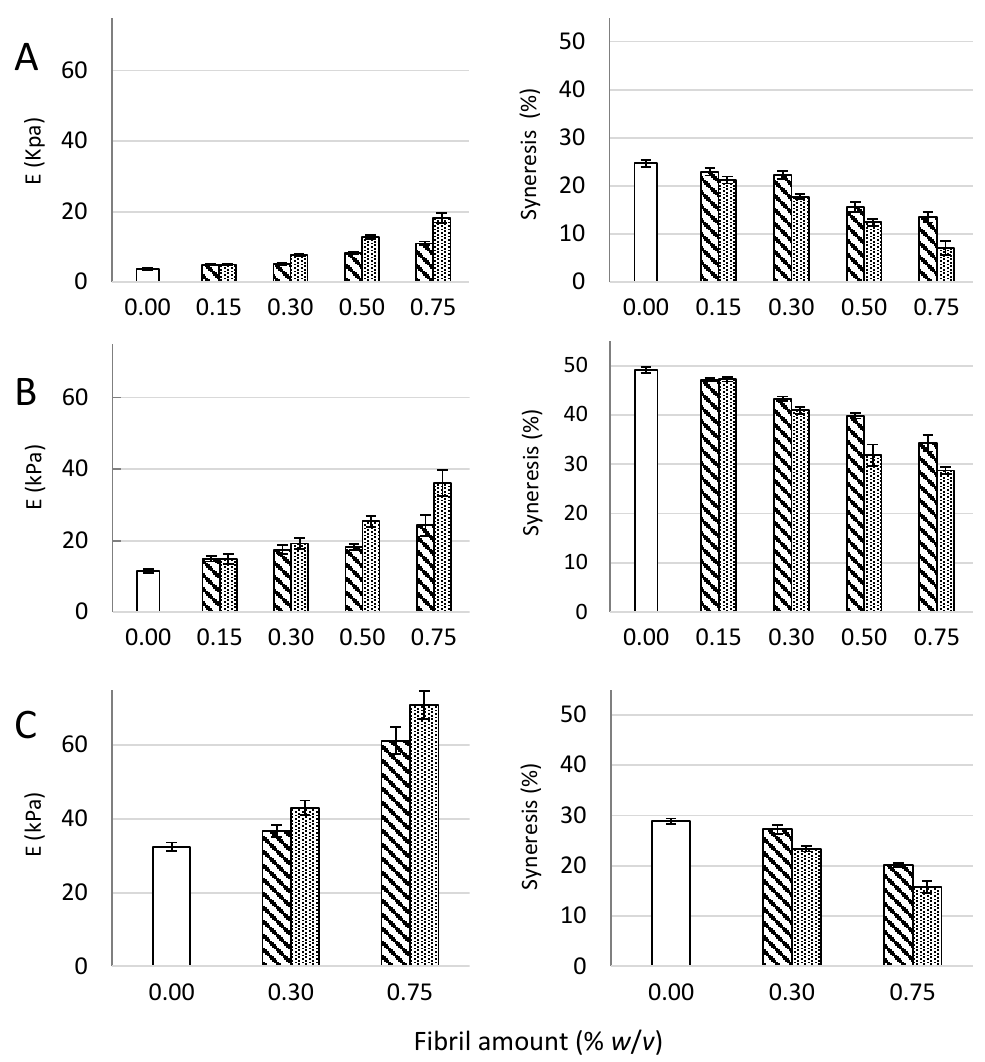
Figure 1. Young’s modulus (E, left panel) and syneresis (right panel) of alginate-CNF composite Ca-gels made from 1% ( w / v ) D. potatorum ( A ), M. pyrifera ( B ), and L. hyperborea ( C ) alginates and 0–0.75% ( w / v ) mechanically-fibrillated ( ) and oxidized CNF ( ). Bars are means ± standard deviations, shown for n = 5–8 gels. P -values are presented in Tables B1 and B2 in Appendix B.